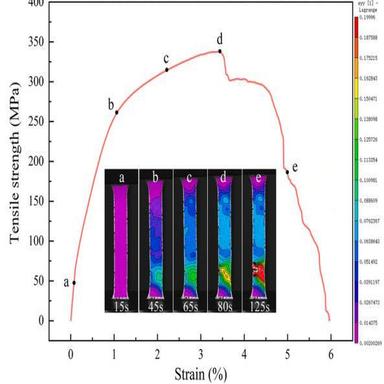
Fracture morphologies of the FGM. (a – e) Fracture morphology of the FGM with different contents of IN625, (f) high magnetization of the box area with dash line in.